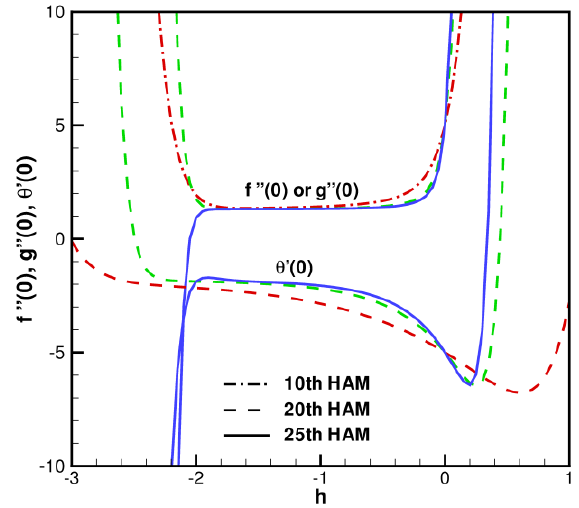
Figure 2. Curves f ηη ( η ) , g η ( η ) change with h when β = 5, η = Figure 2. Curves ()()   g f , change with h when 5 =  , 0 =  .